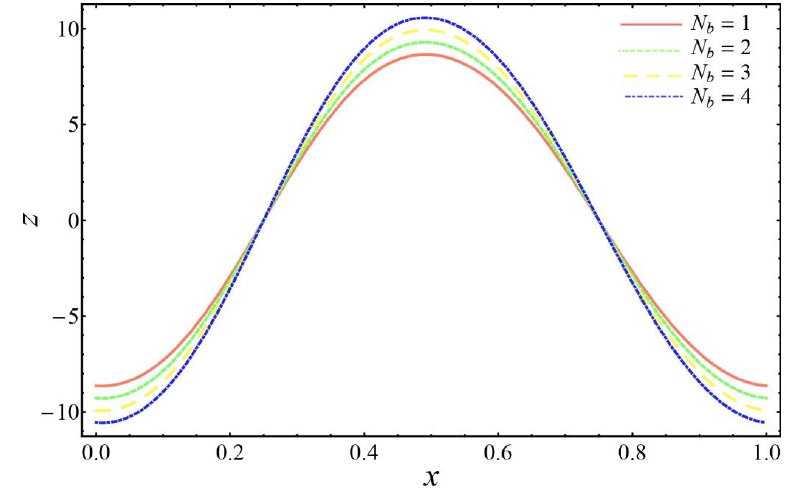
Figure 11. Alteration of 𝐿 𝑑 on γ when 𝑥 = 0.1; 𝑡 = 0; 𝑄 = 10; 𝛽 = 0.2; 𝜖 = 0.1; 𝑁 𝑏 = 2; 𝑁 𝑑 = 1; 𝑘 = 1.5.